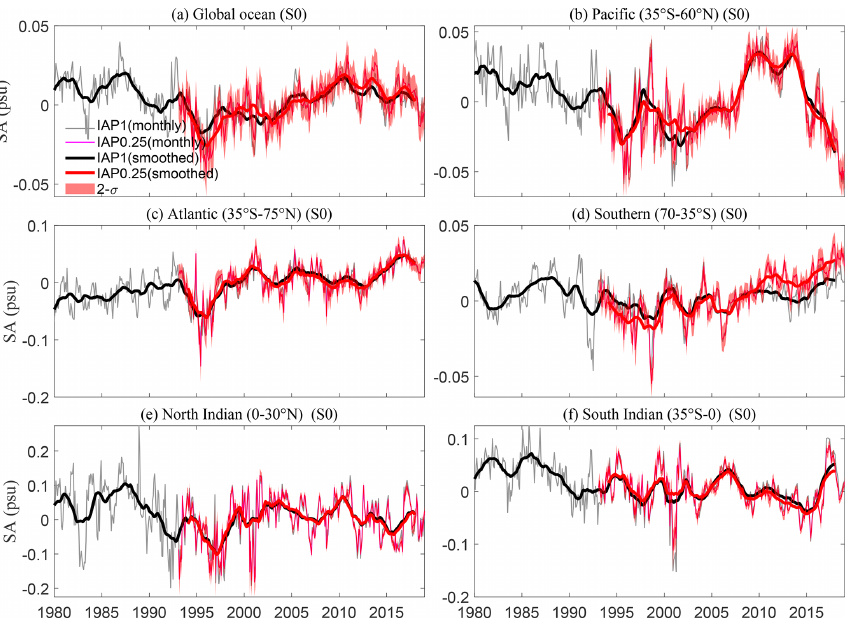
Figure 14. The global (a) and basinal (b–f) salinity anomalies (SA) time series at the surface from 1993 to 2018 for IAP1 ◦ and IAP0.25 ◦ respectively. Both monthly and 12-month running smoothed time series are presented; all data are relative to a 1993–2015 baseline.